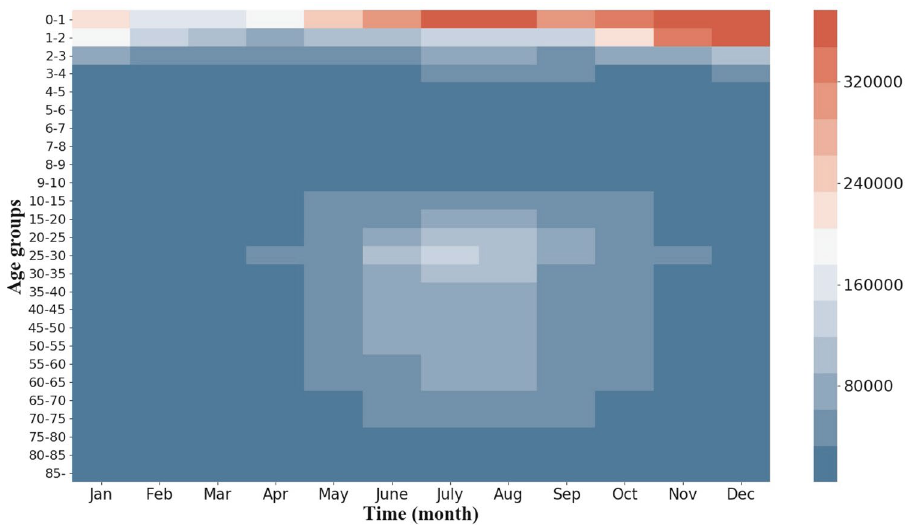
Figure 2. Seasonal and age-specific numbers of infectious diarrhea cases in mainland of China, 2005–2017. (See Supplementary Table 1 in the Supplementary material to obtain the detailed data). The heat map is created by package seaborn in Python 62 .